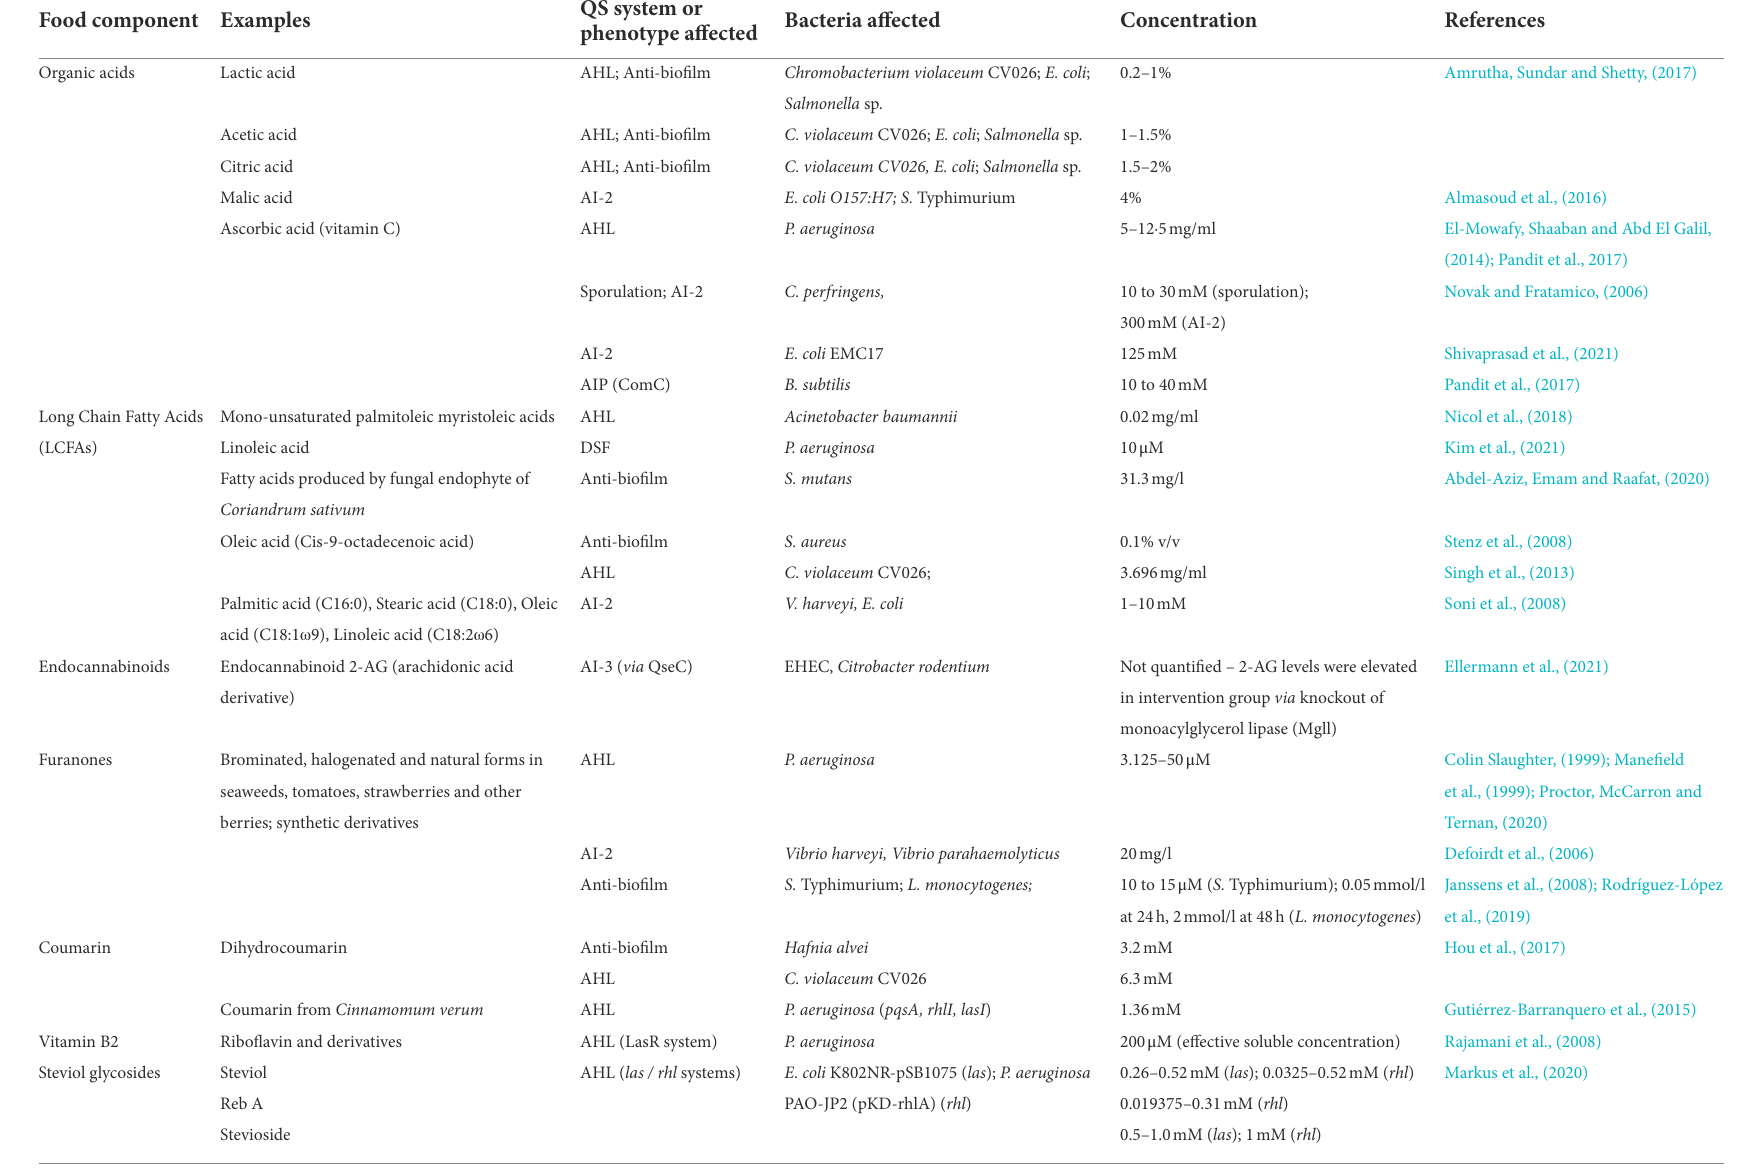
TABLE 2 Overview of components of food matrices which can mediate bacterial Quorum Sensing Inhibition (QSI) or related phenotypes, such as biofilm inhibition and